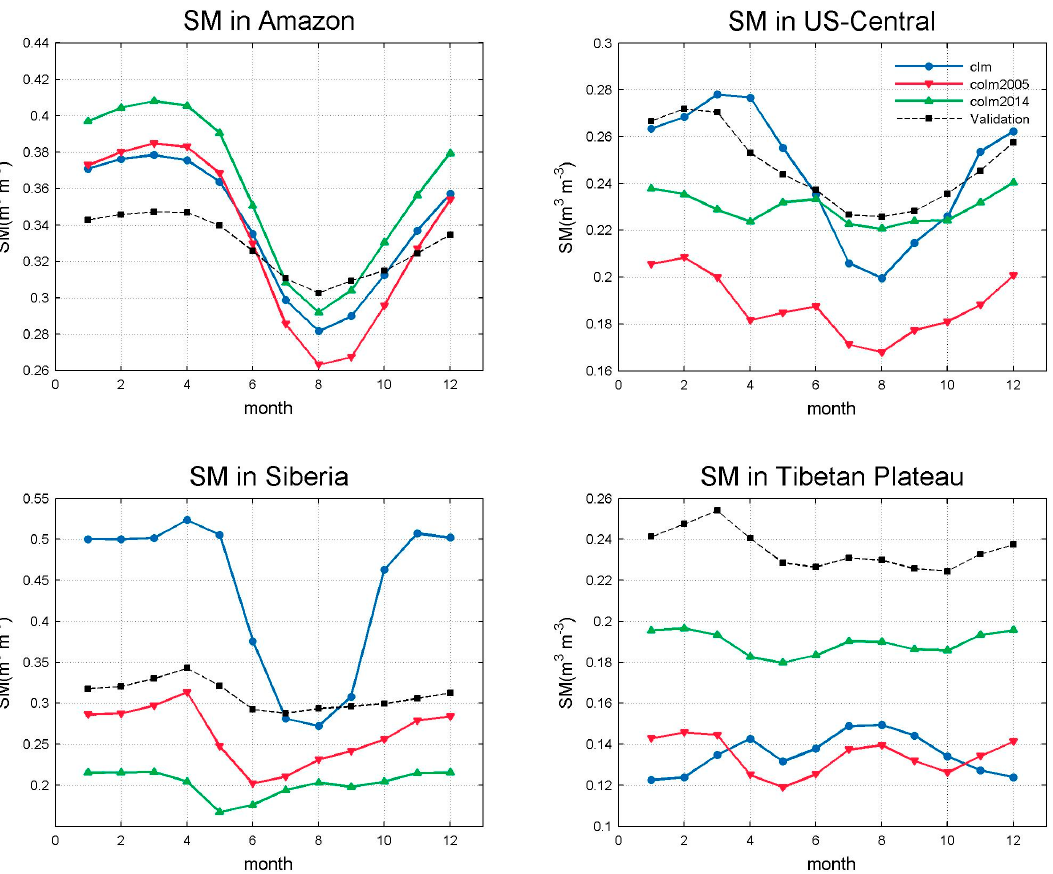
Figure 8. Same as Figure 3, but for surface soil moisture (Units: m 3 m − 3 ).